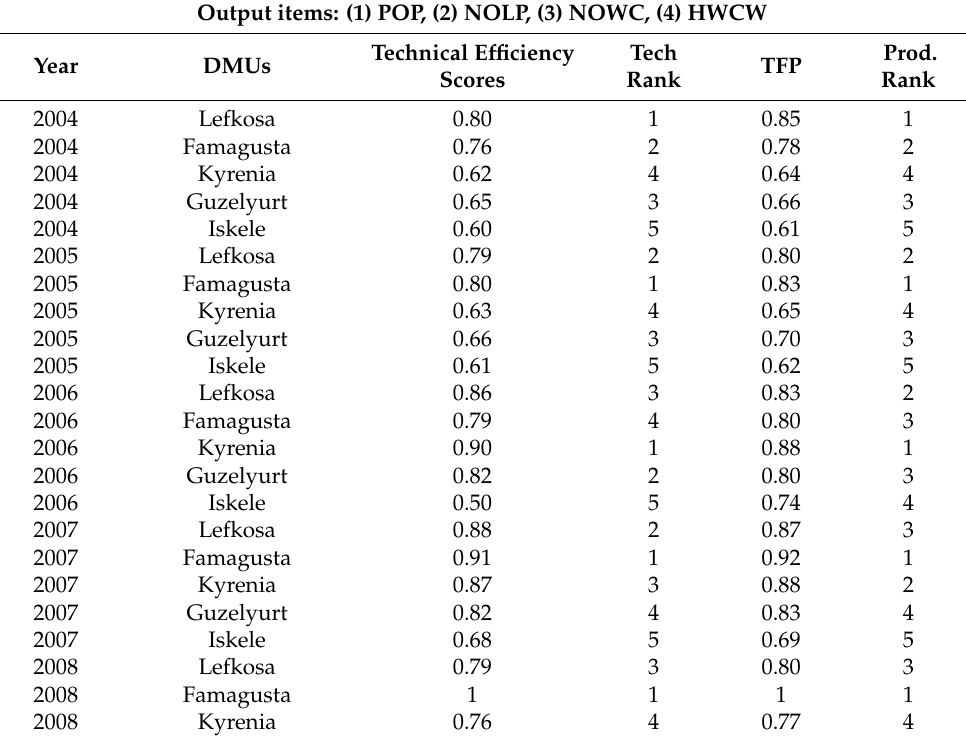
Table 8. Malmquist